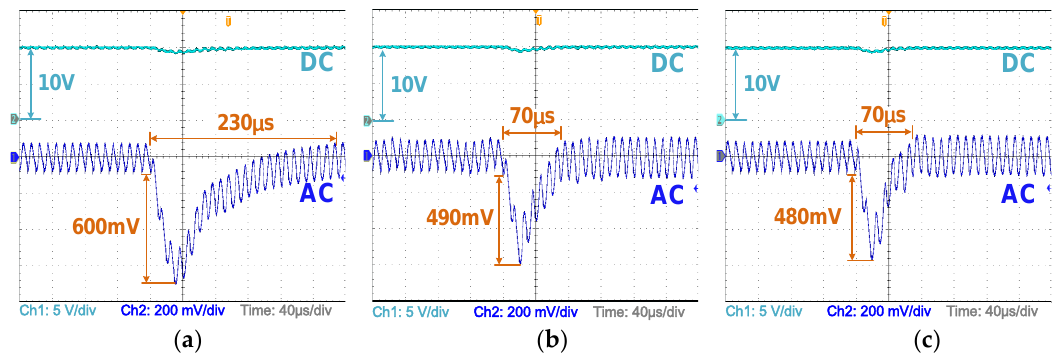
Figure 14. Output voltage transient responses when the load steps from 10 Ω to 5 Ω ( a ) PI control ( b ) discrete charge balance (DCB) control ( c ) linearized discrete charge balance (LDCB) control.